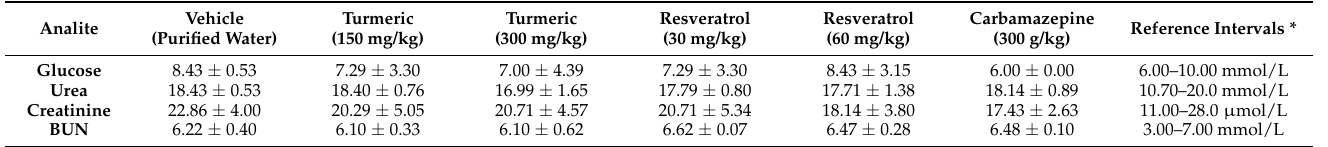
Table 1. Post-status epilepticus blood chemistry of rats treated with the vehicle, turmeric, resveratrol, or